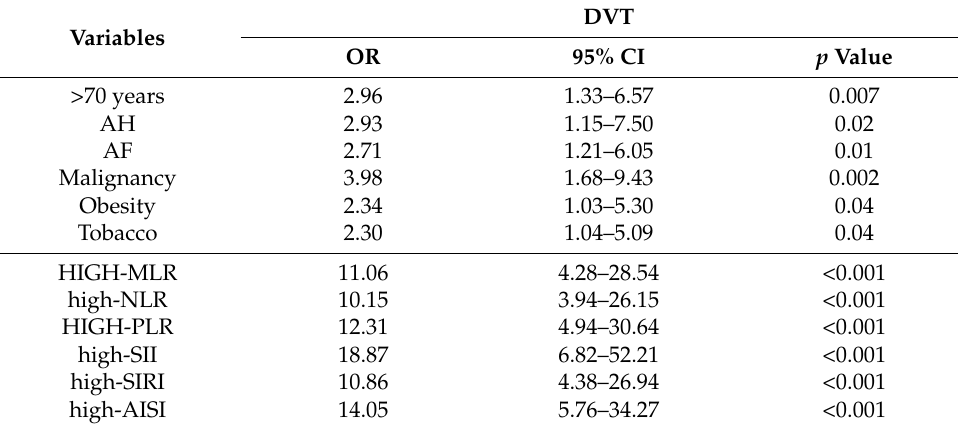
Table 4. Multivariate analysis for predictors of